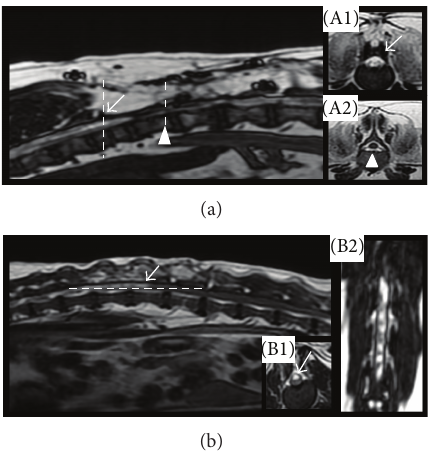
Figure 3: (a) MRI of a dog with syringomyelia (dog 4) showing area of hypersignal ((A1): white arrow) indicating spinal cord degeneration and an area void of spinal cord presence signal ((A2): arrow head). (b) MRI of a dog (dog 3) with a hypersignal (white arrow), indicating spinal cord degeneration also within axial (B1) and dorsal (B2) aspects regions.